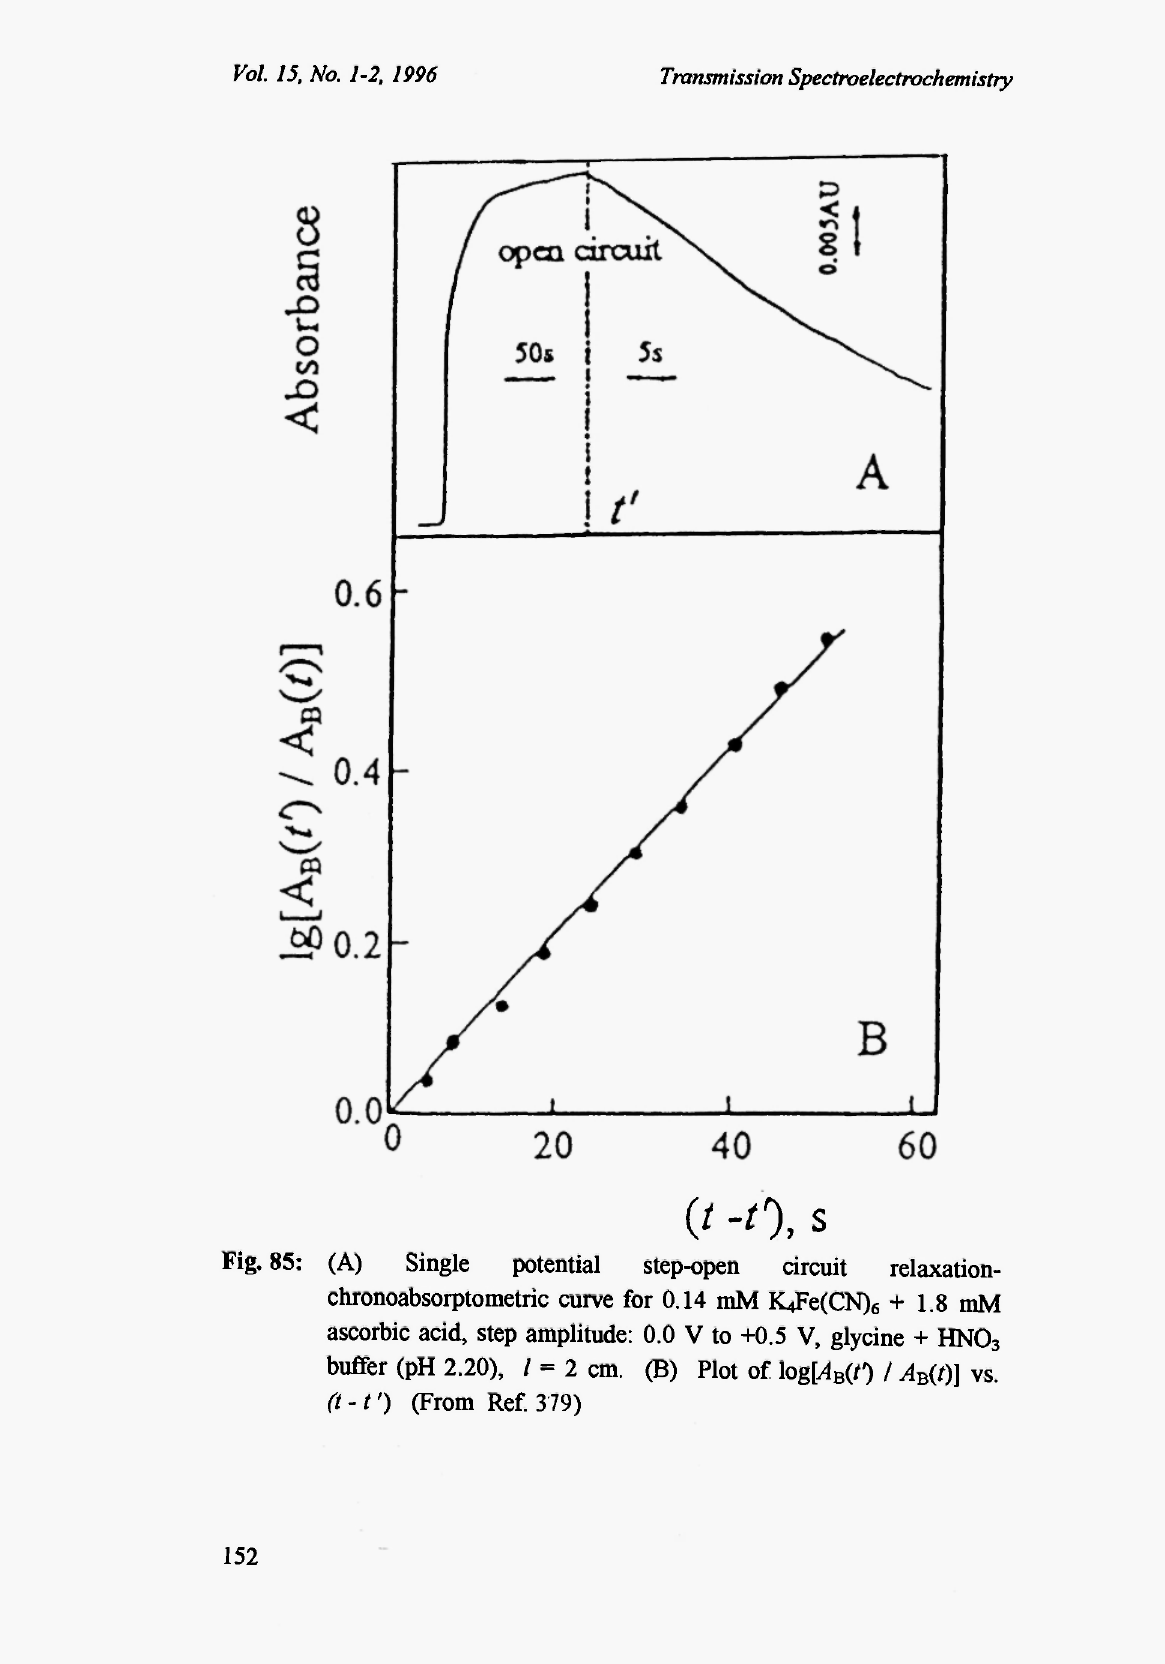
{t - O, S + 1.8 mM 6 3 (0 / A (t)] vs. B B